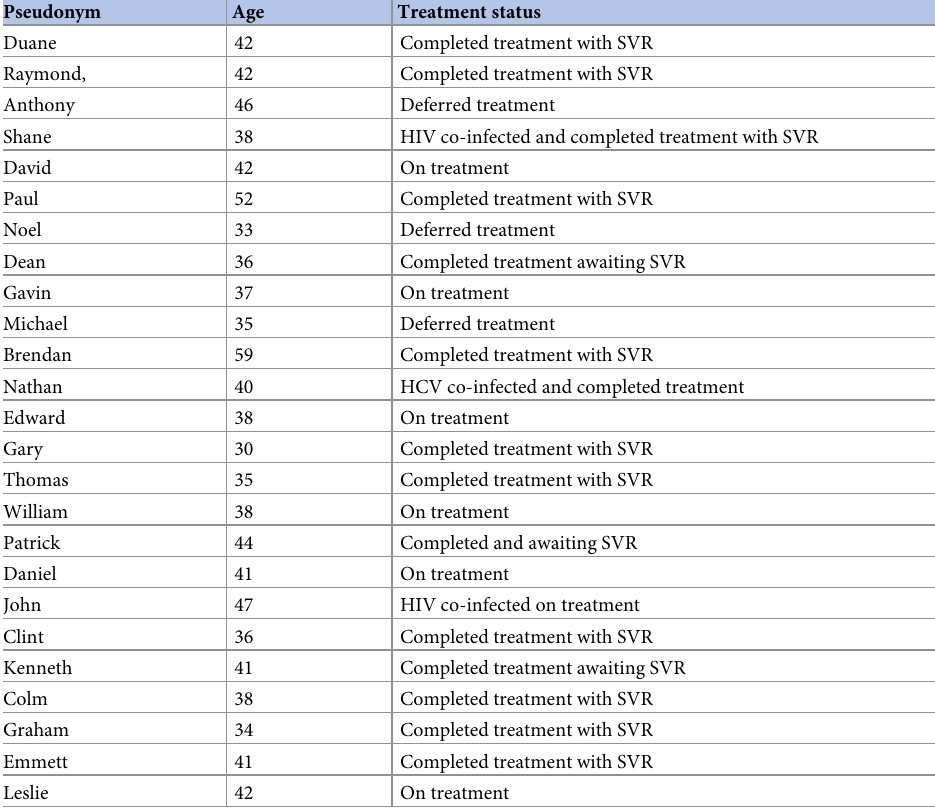
Table 1. Description of study